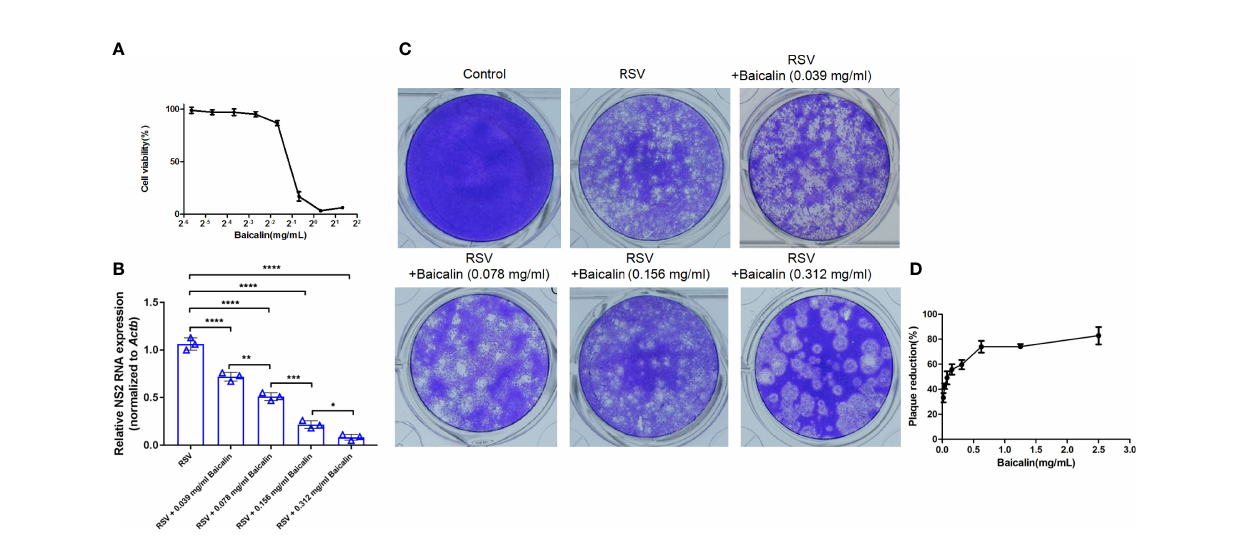
FIGURE 1 | Baicalin demonstrates potent anti-RSV activity in vitro . (A) The cytotoxic in fl uence of baicalin was determined by assessing cell viability by CCK-8 assay. HEp-2 cells were treated in triplicate with baicalin increased concentrations for 72 h. Absorbance at 570 nm in relation to that of mock treated control was plotted for evaluation of the TC 50 value. (B) Expression of viral transcripts of the NS2 gene was analyzed by RT-qPCR in HEp-2 cells infected with RSV (MOI = 3) and treated with the indicated doses of baicalin. Data were normalized to Actb expression. Results are shown as mean ± SD (n = 3); * P < 0.05, ** P < 0.01, *** P < 0.001, **** P < 0.0001 – ANOVA with Tukey ’ s post-hoc test. (C, D) Baicalin IC 50 was determined through plaque reduction assessment in HEp-2 cells infected with RSV in the presence of the indicated doses of baicalin (C) . The number of plaques was counted and plotted as the percentage of plaque inhibition in relation to untreated cells, after 72 h (D) .